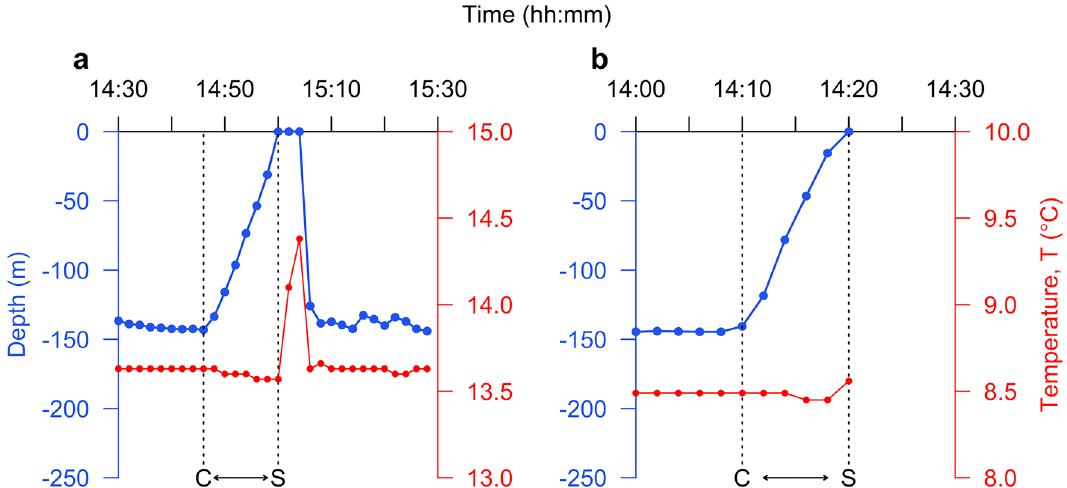
Figure 2. Temperature-depth profiles collected from individual ascents associated with recreational angling events, including ( a ) angling events that occurred during individuals’ time at liberty and ( b ) archival tag retrieval events, in known locations were used to validate modelled temperature-depth profiles . Blue lines show depth time series (left axis) and red lines show temperature time series (right axis). Ascents were defined from the time of the last depth observation preceding the capture ascent (labelled C) to the time of the first observation at the surface (labelled S).